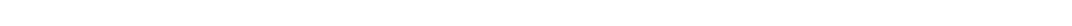
FIGURE2 presses as well as in (D) the number of cocaine infusions between future vehicle (Veh)- and prazosin (Praz)-treated subjects. (E) Intra-VTA microinfusion of prazosin (Praz 1 µ g/side) on day 9 had no effect on the numbers of active and inactive lever responses and on (F) the number of cocaine infusions. (G) Intra-VTA α 1 -AR blockade had no effects on the numbers of active lever presses over time. Similarly, prazosin treatment on day 9 had no effects on (H) the numbers of active and inactive lever presses and (I) cocaine infusions, 24 h after treatment (on day 10). (J) Finally, prazosin microinfusion on day 9 had no effects on active lever responding during time-out. (K) Localization of histologically verified cannula placements. Data are presented as individual data points as well as the mean and SEM. Act, active lever; Inact, inactive lever.